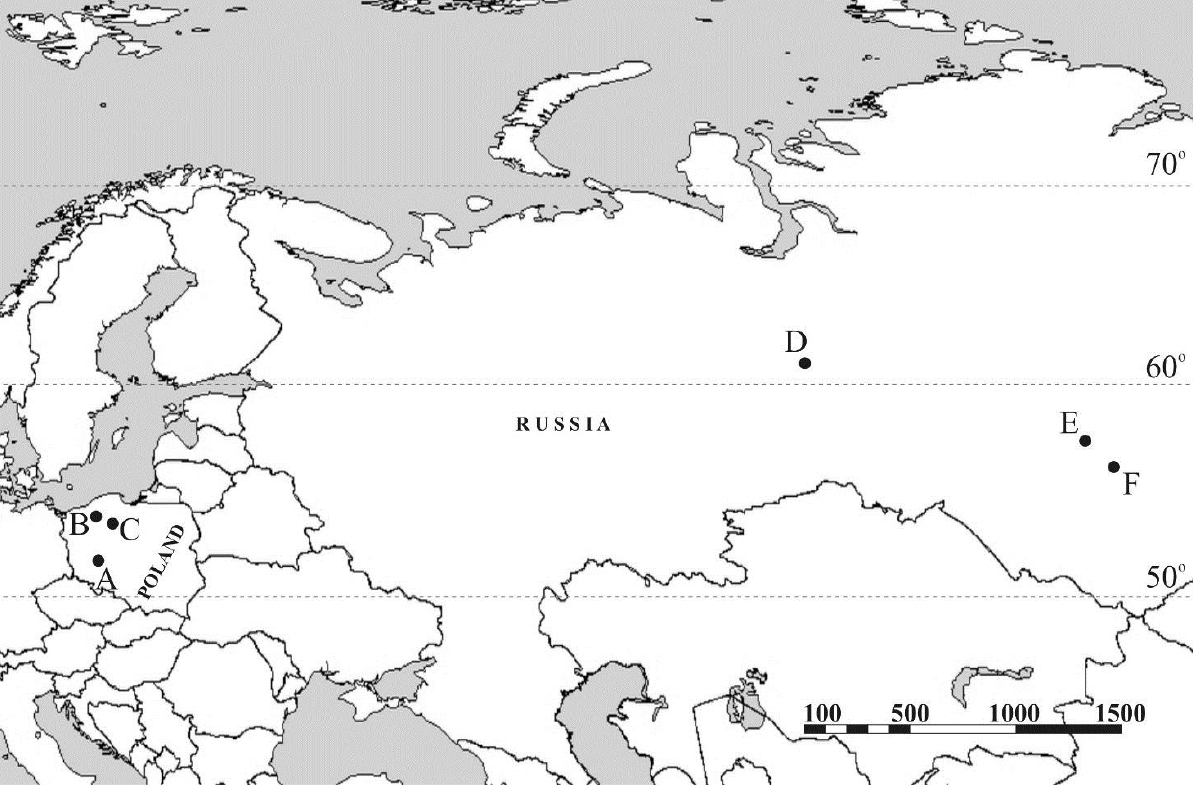
Figure 1. Location map of study peatlands. A: General Dezydery Chłapowski Landscape Park; B: Kusowo; C: Stążka; D: Mukhrino; E: Vasyugan; F: